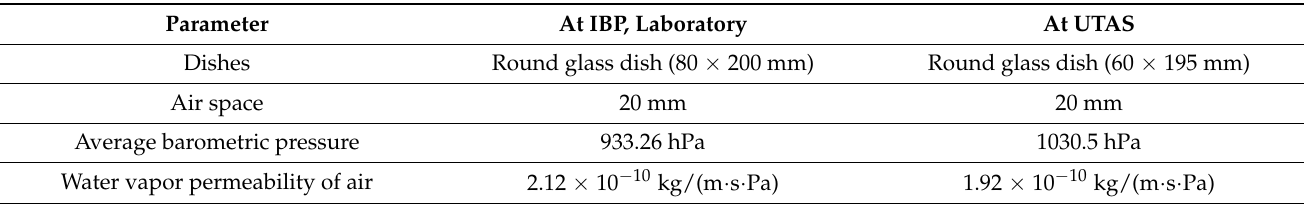
Table 2. Summary of testing